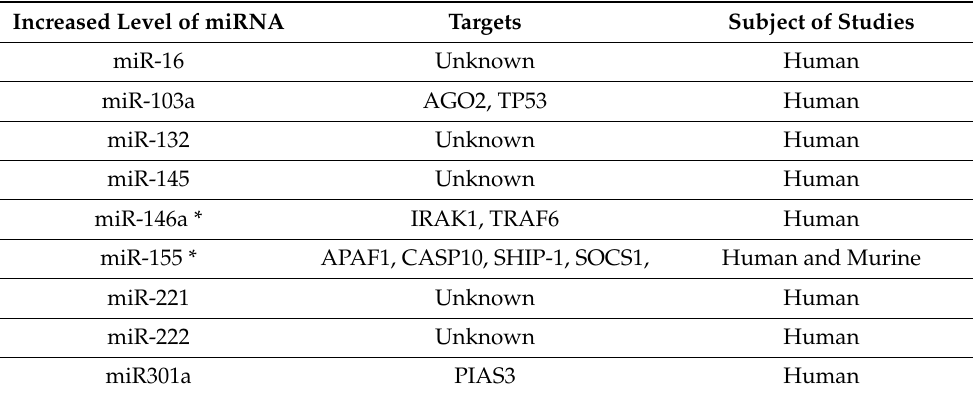
Table 1. List of increased levels of miRNA in PBMCs with their targeted genes [8].